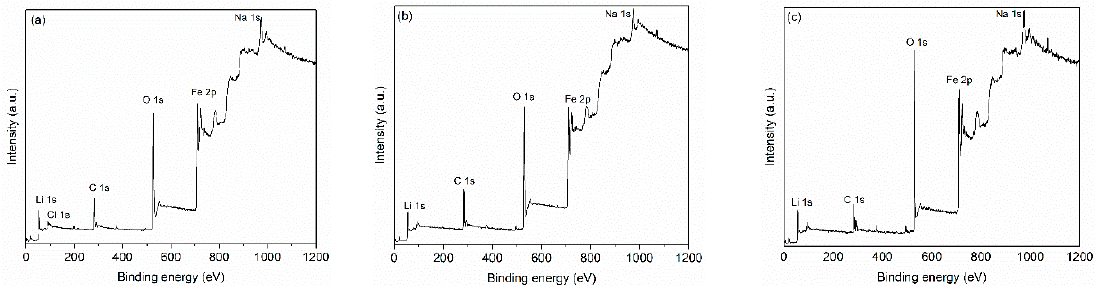
Figure 4. XPS spectra of the samples heat-treated at ( a ) 600 °C, ( b ) 800 °C, and ( c ) 1000 °C.